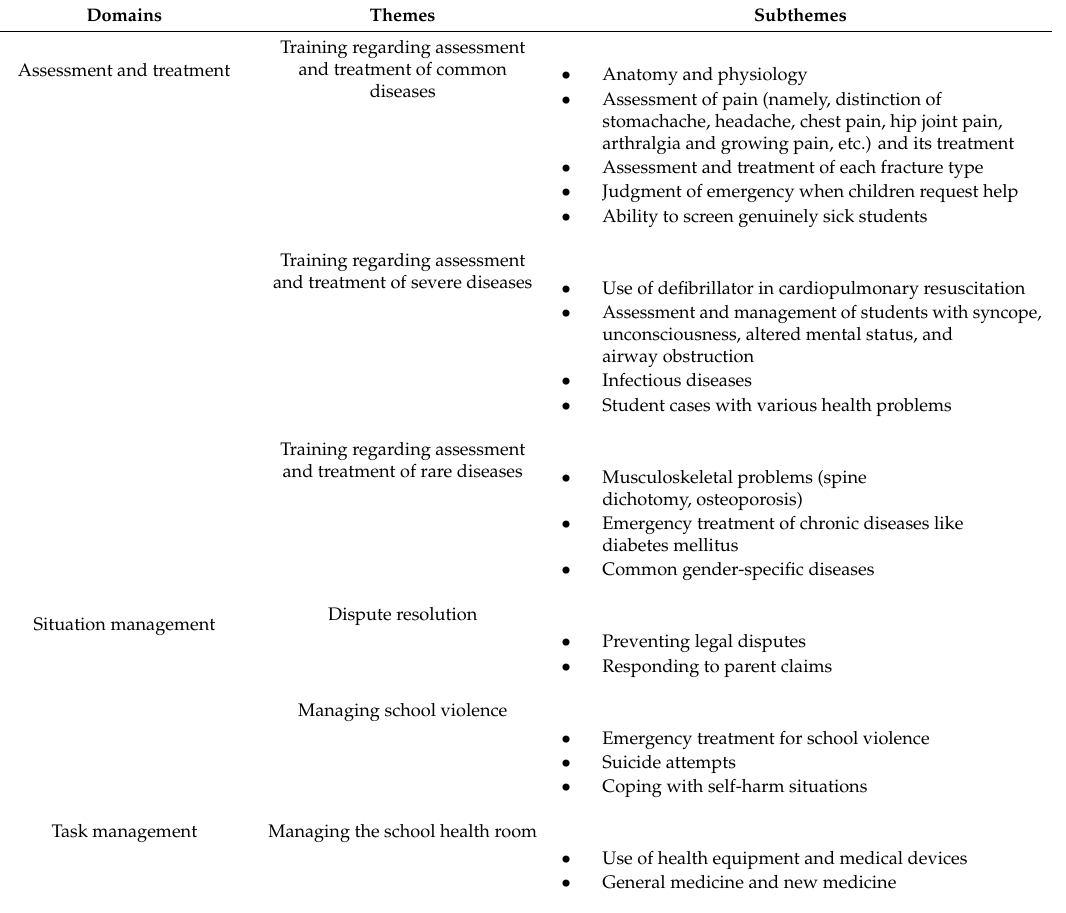
Table 1. Preferred Themes of Continuing